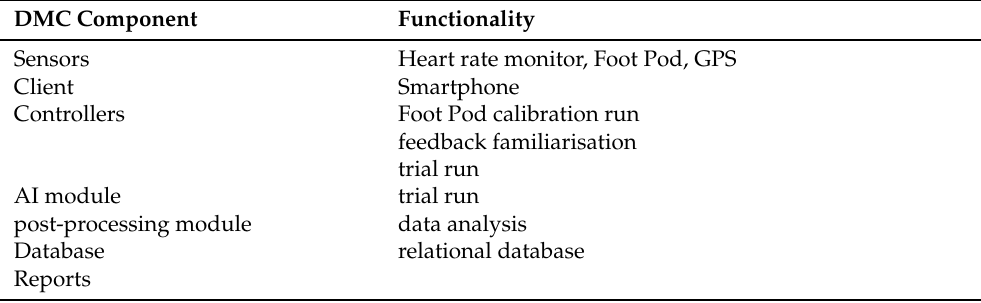
Table 2. Example of a DMC-styled feedback